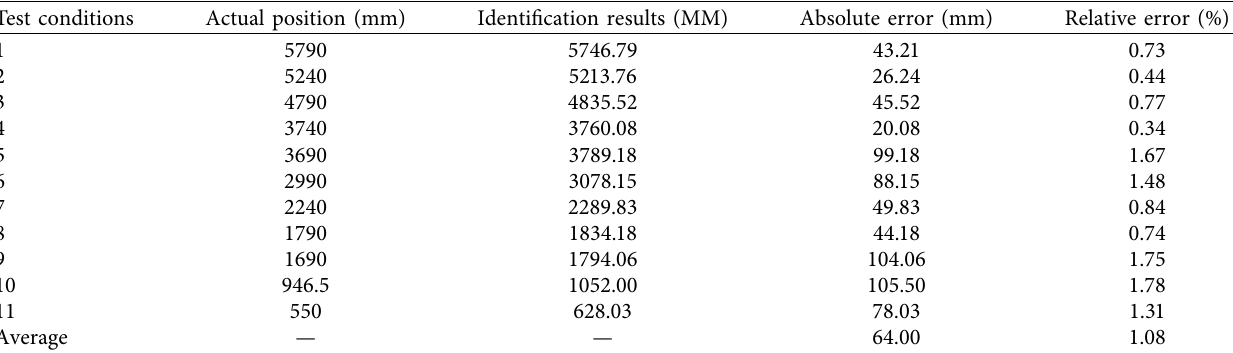
Table 11: Location results of the noiseless GA-BP neural network.